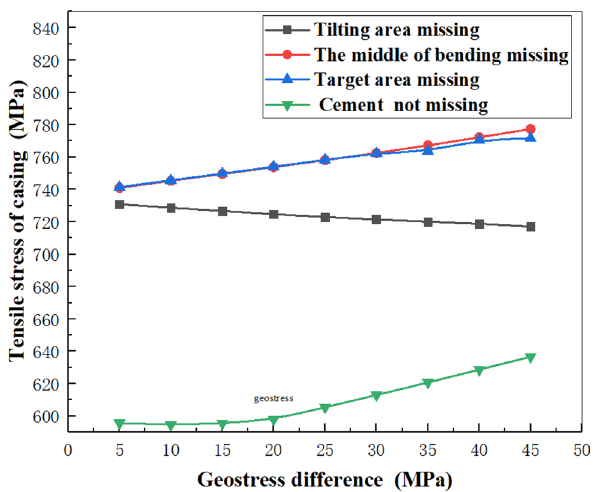
Fig. 10 Change curve of casing tensile stress with missing cement at different